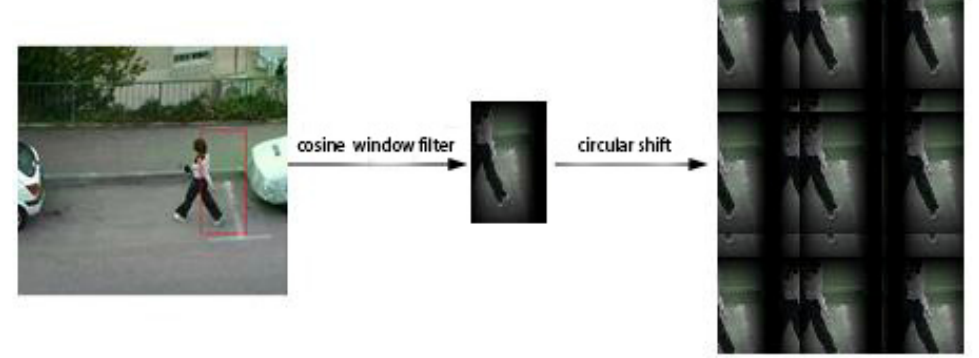
Figure 5. Extraction process of cyclic samples.